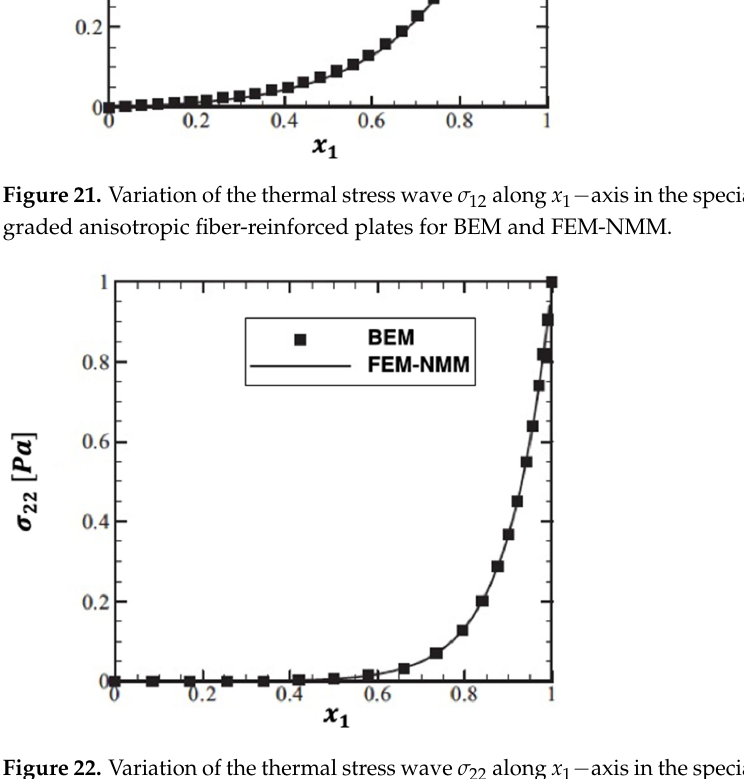
Figure 22. Variation of the thermal stress wave 𝜎 (cid:2870)(cid:2870) along 𝑥 (cid:2869) – axis in the special case of the func- tionally graded anisotropic fiber-reinforced plates for BEM and